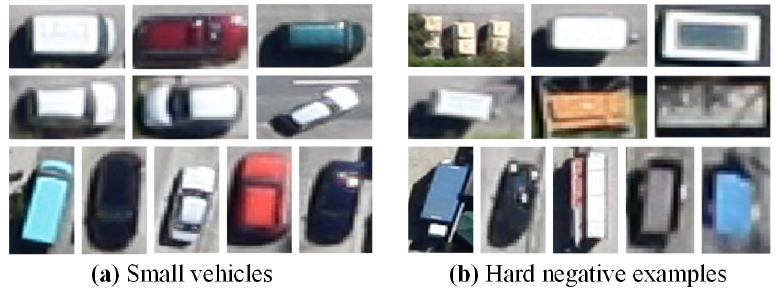
Figure 1. Two challenges for vehicle detection in aerial images. ( a ) small vehicles; ( b ) hard negative